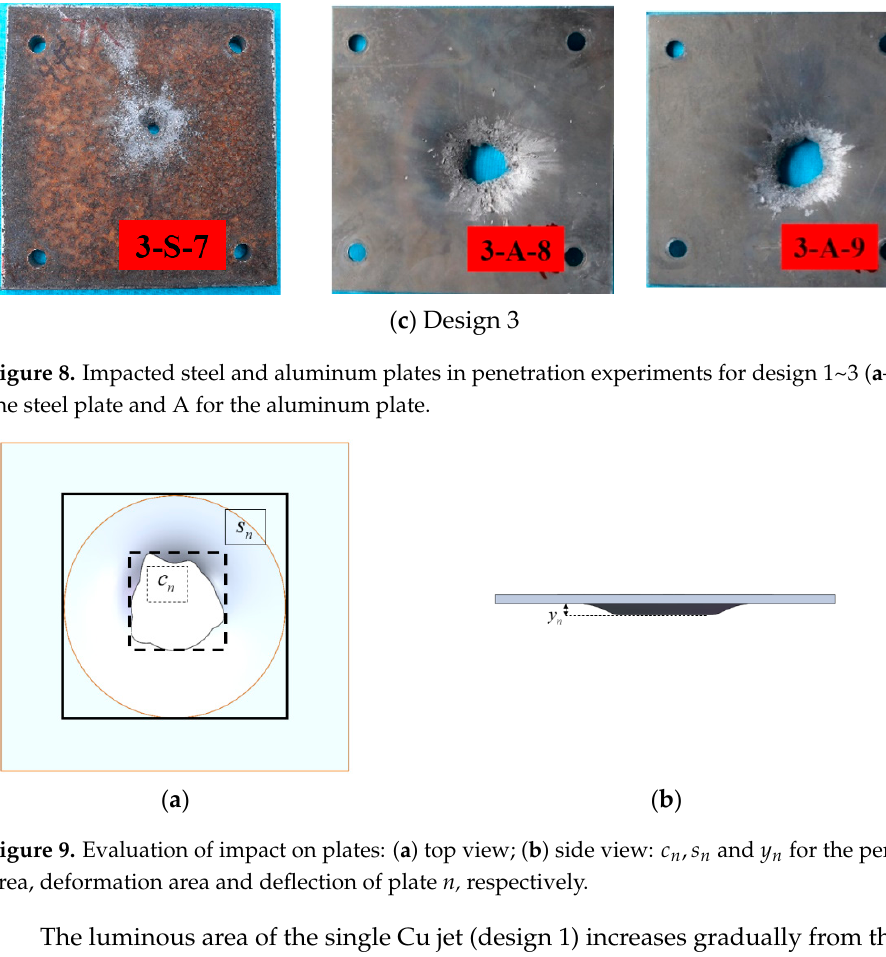
Figure 8. Impacted steel and aluminum plates in penetration experiments for design 1~3 ( a – c ): S for the steel plate and A for the aluminum plate.